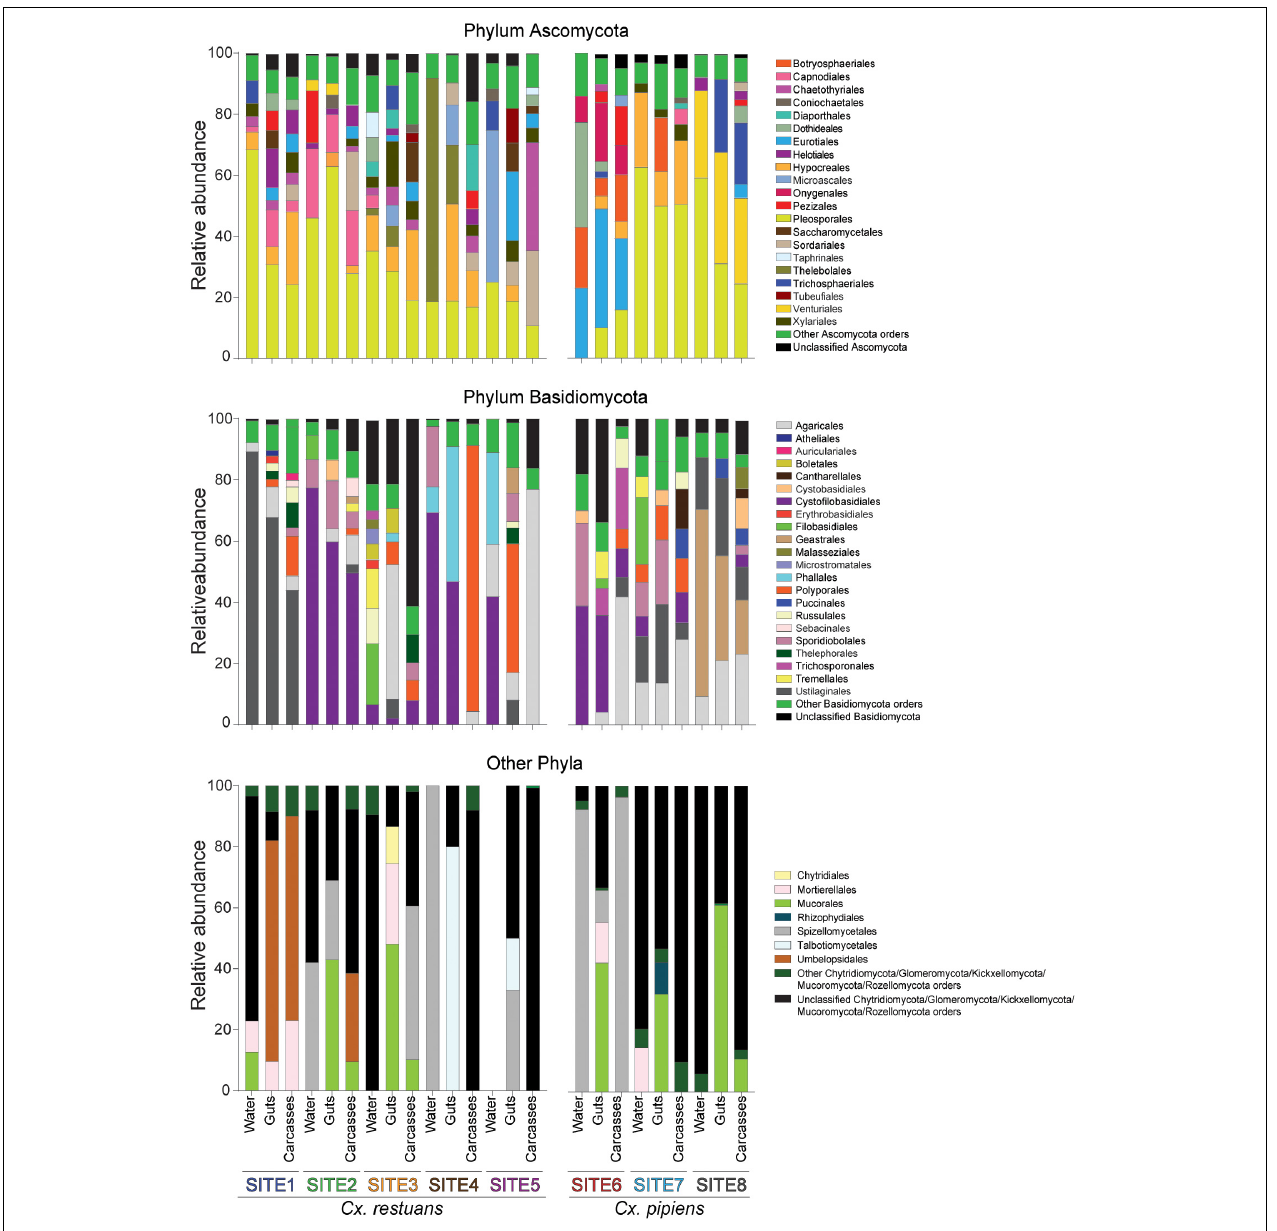
FIGURE 2 | Bar plot of the relative abundances of fungal OTUs at the phylum and order levels across breeding water and larval guts and carcasses of both mosquito species. Gut and carcass samples presented here are the combined reads of all guts and carcasses within each larval breeding site. Low abundance orders within each phylum are combined into “other orders”